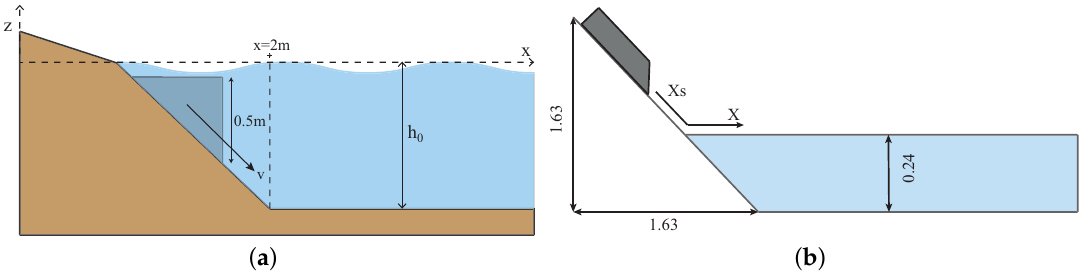
Figure 1. Experimental setup. ( a ) Submarine landslide of Heinrich [7]. ( b ) Subaerial landslide of Heller et al.